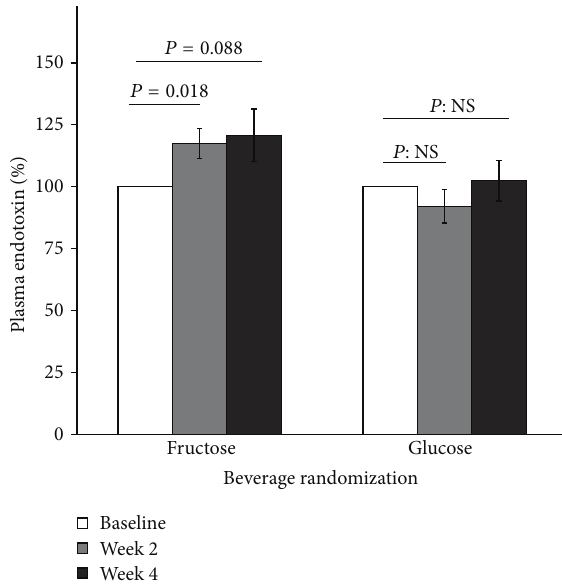
Figure 3: Percentage change of plasma endotoxin level in adoles- cents with NAFLD after 2- and 4-week ingestion of study-provided fructose or glucose-only beverages. Baseline values were set as reference (100%). Error bars stand for